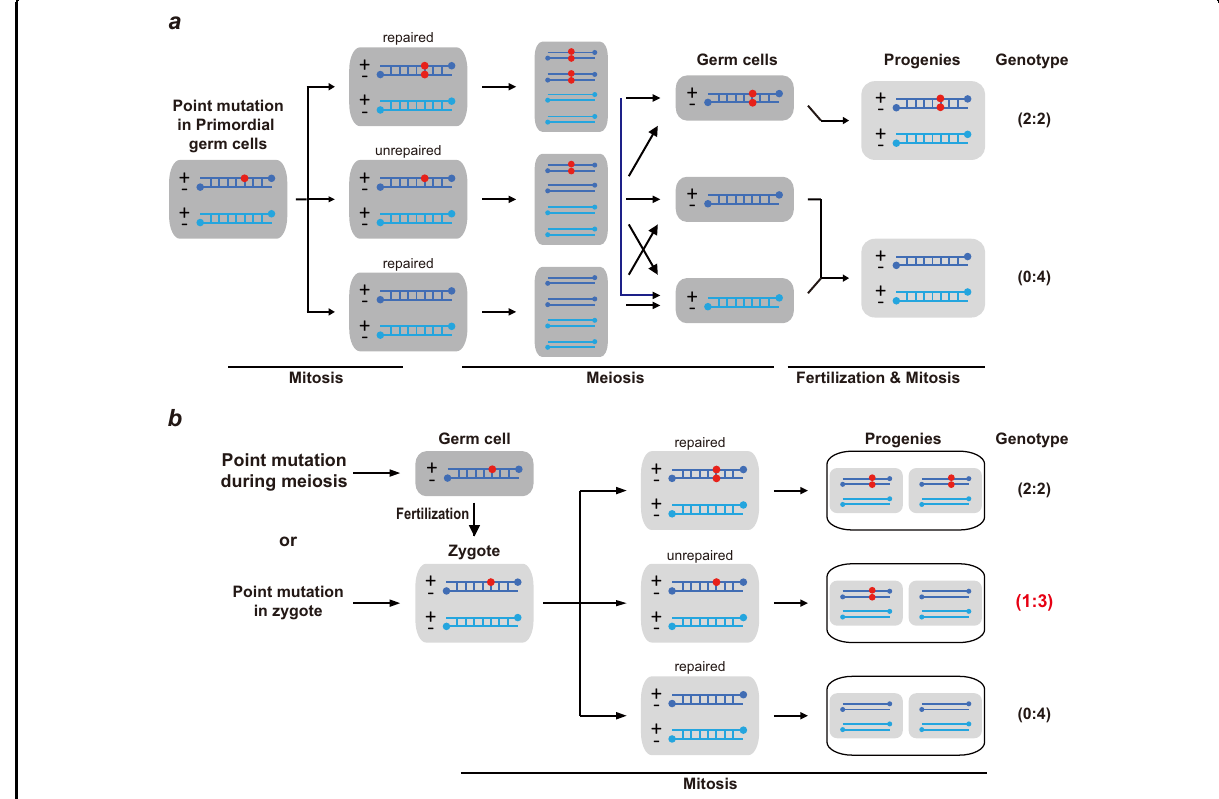
Fig. 4 Illustration for the potential origin of DNMs based on the detected genotypes in F2 embryos. a When a point mutation is generated in primordial germ cells, whether it is repaired or not during mitosis and meiosis, the locus of a progeny must has a genotype as either 2:2 or 0:4. b When a point mutation is accumulated during meiosis or in zygote, the locus of a progeny has a genotype as 2:2 (or 0:4) when this mutation is repaired. When this mutation is not repaired, the locus of a progeny has a genotype as